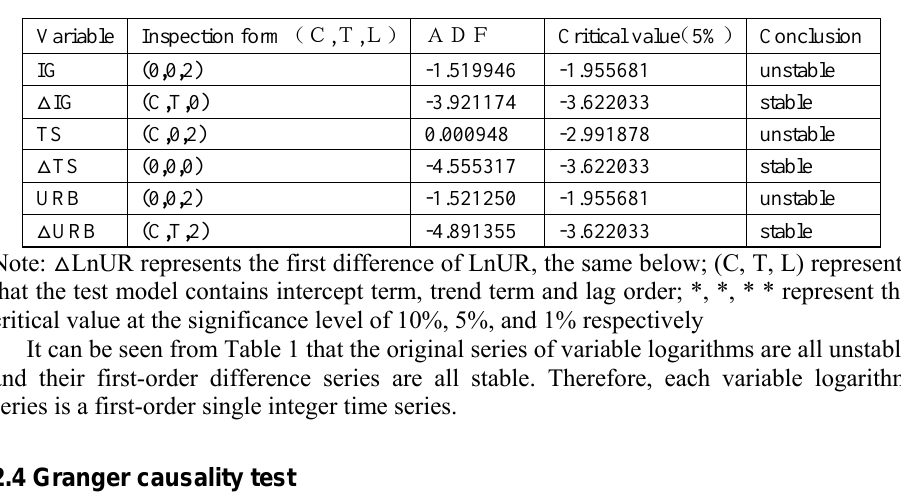
Table 1. ADF unit root test